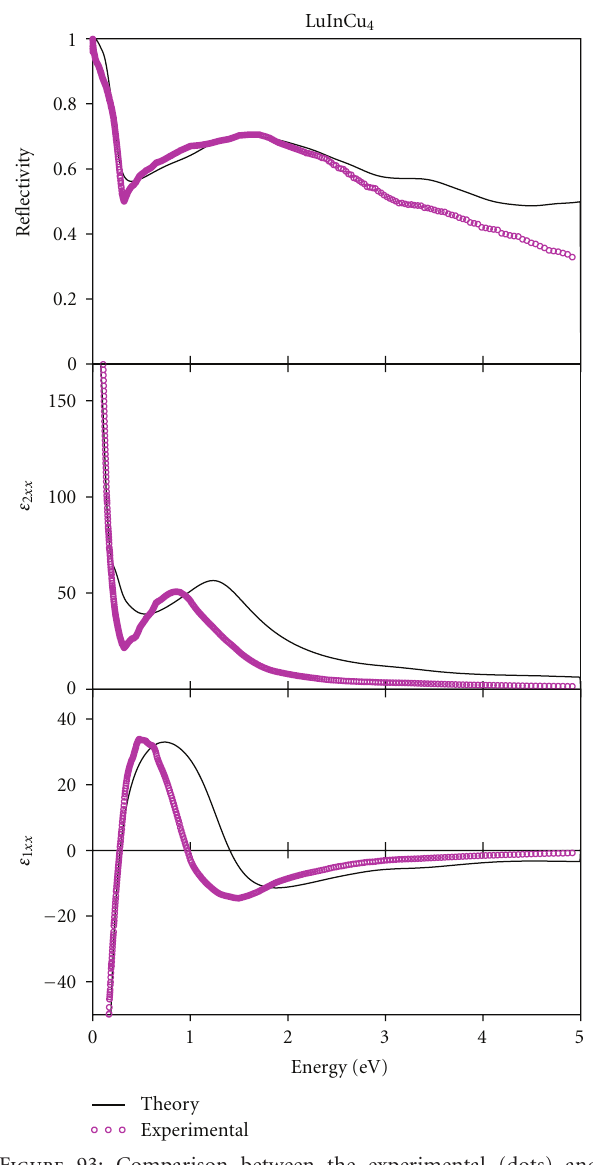
Figure 93: Comparison between the experimental (dots) and calculated optical reflectivity R ( ω ), real part ε 1 ( ω ) and imaginary part ε 2 ( ω ) of the dielectric function of LuInCu 4 calculated within LSDA (solid line) [475].